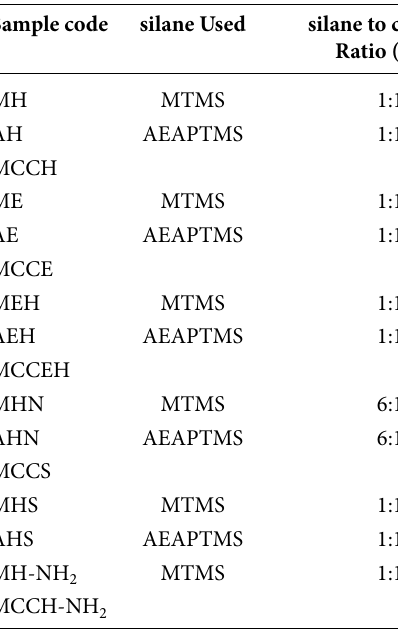
Table 1. Composition of obtained MCC samples